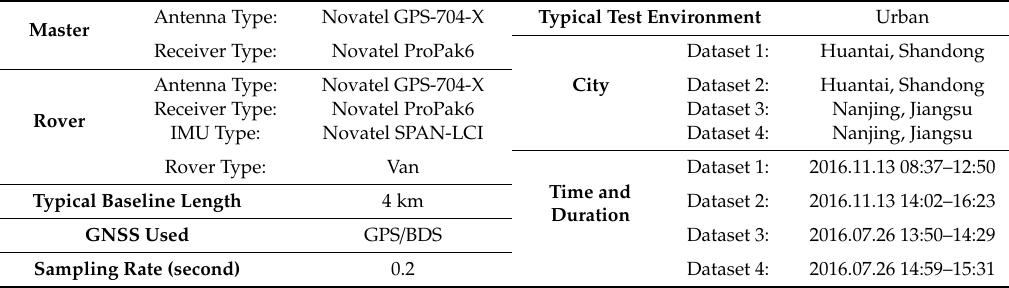
Table 10. Hardware information and test settings. IMU: inertial measurement unit.